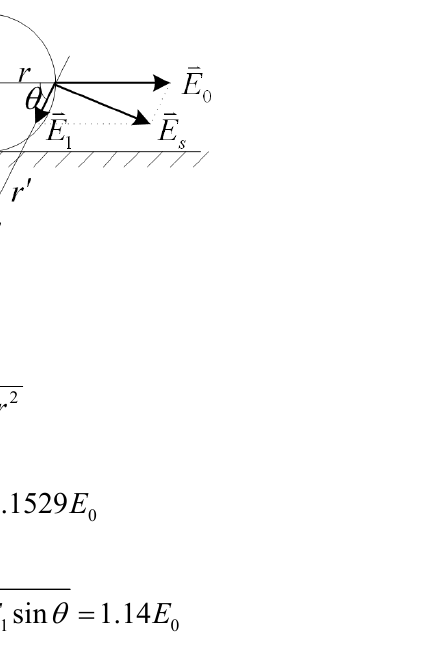
Figure 1. Schematic diagram of electric field at arc